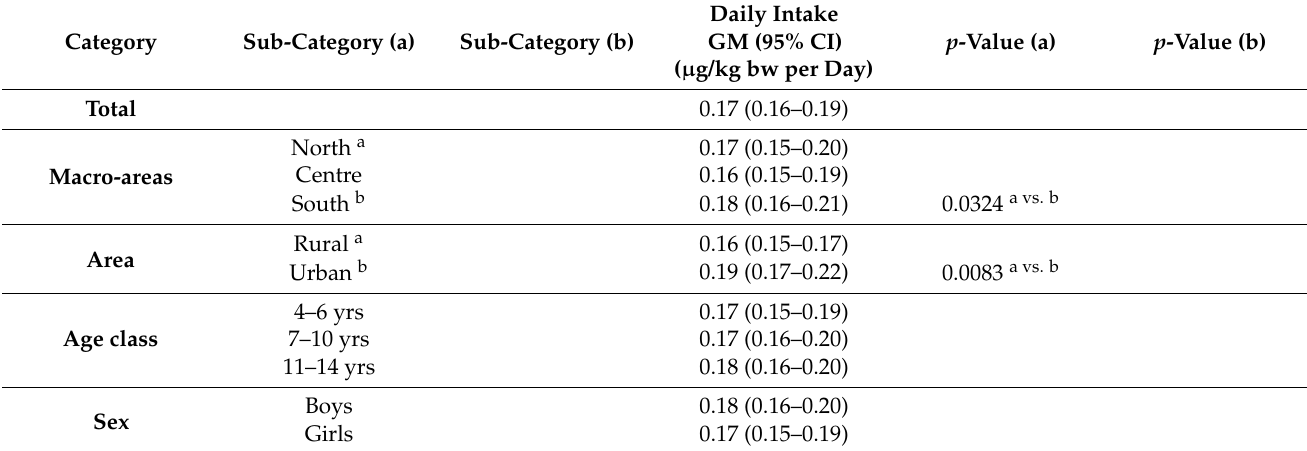
Table 3. Estimated daily intake (µg/kg bw per day) of BPA in Italian children according to sex, age and residing area/macro-area expressed as geometric mean with 95% Confidence Intervals.